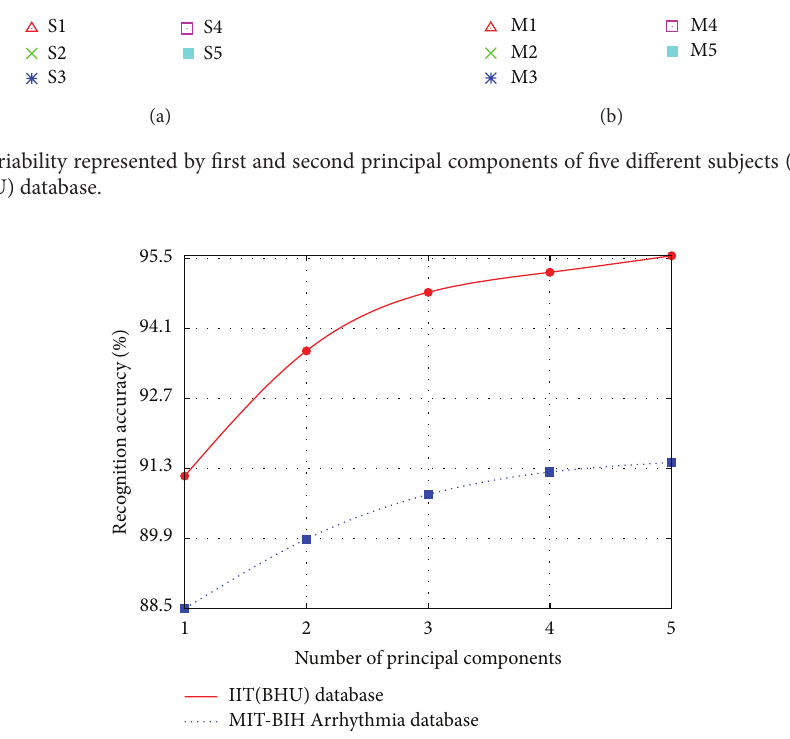
Figure 6: Subjects ECG recognition performance of MIT-BIH Arrhythmia database and IIT(BHU) database. Variations in performance of eigenbeat features depend on the number of principal